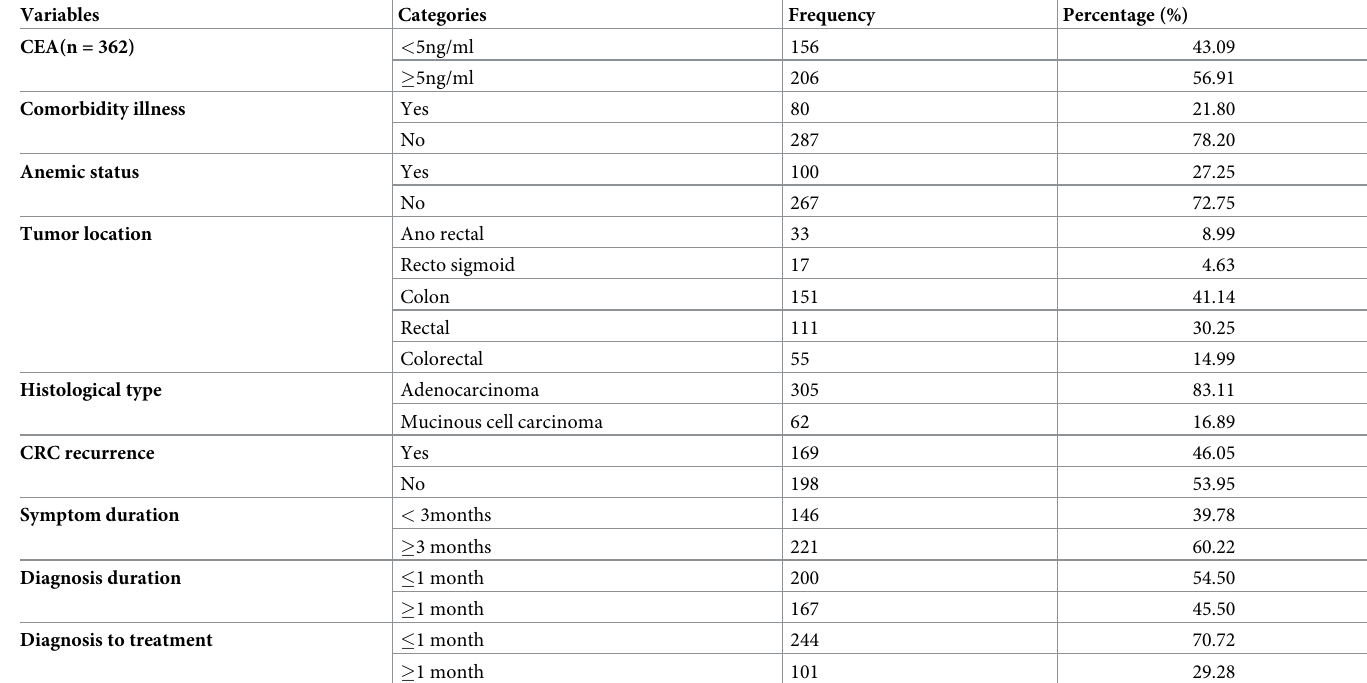
Table 2. Clinicopathological characteristics of study participants (n = 367).